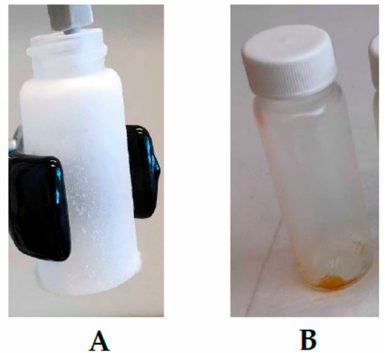
Figure 7. Throttling effect during the extract collection, ( A ): dry ice formation at sudden drop in pressure (250 bar to 0 bar), ( B ): Collection of extract at low pressure drop (50 bar to 0